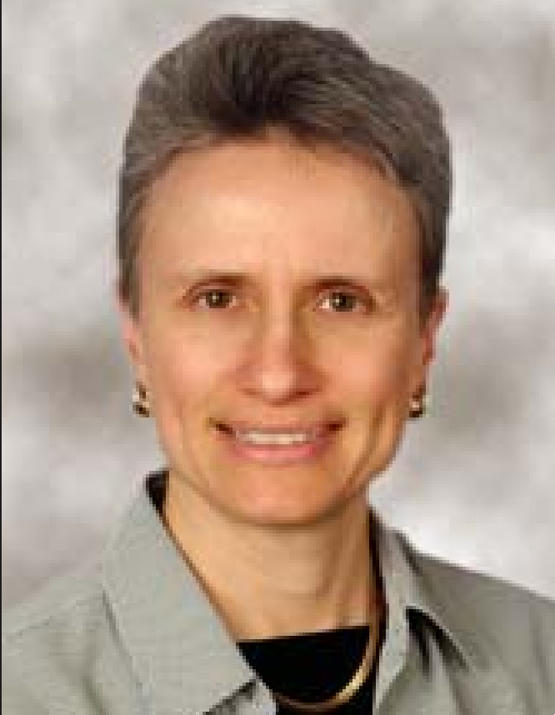
Stephanie London